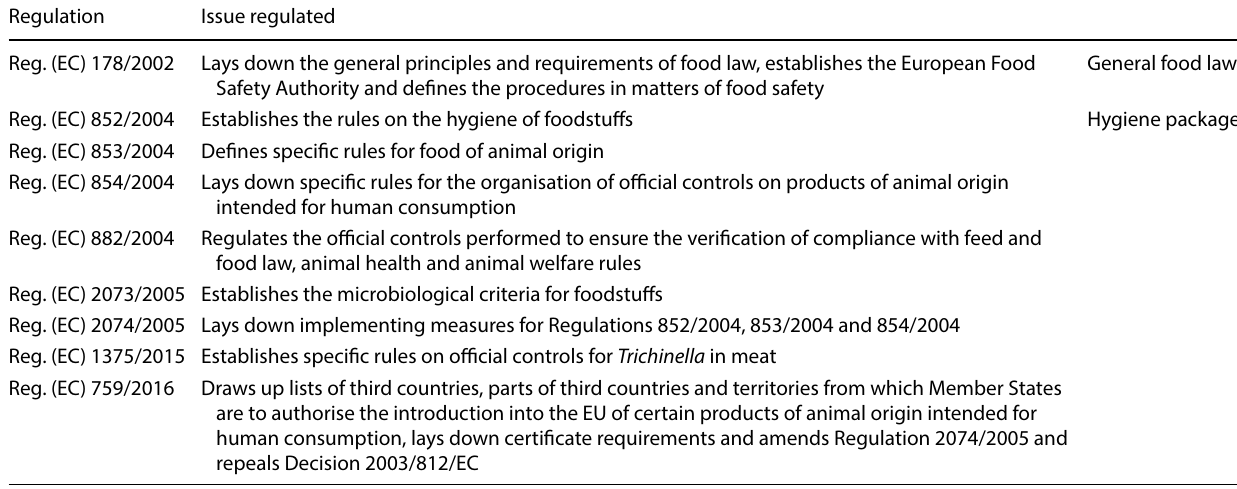
Table 2 European union regulations belonging to the “hygiene